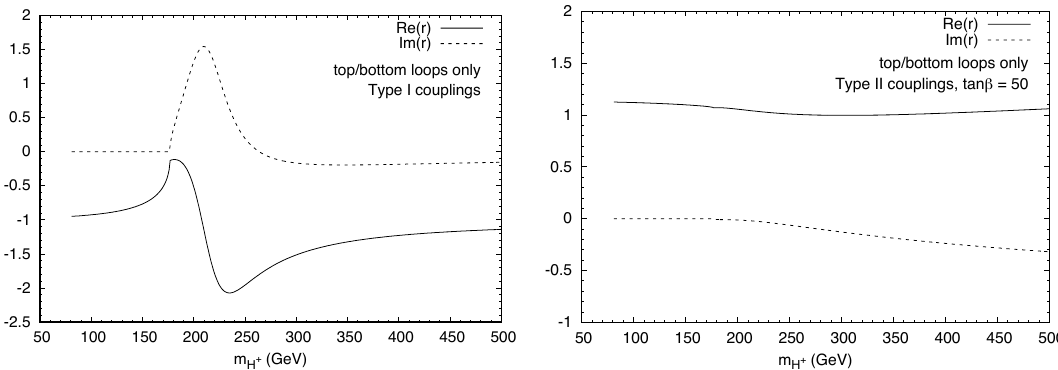
~ S=S including only the loops involving top and bottom Figure 2 . Real and imaginary parts of r (cid:17) quarks, for H + couplings as in the Type-I 2HDM or GM model (left) and as in the Type-II 2HDM with tan (cid:12) = 50 (right).